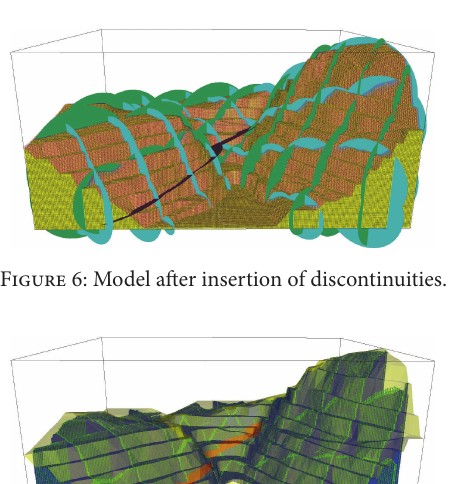
Figure 5: The model after excavating.